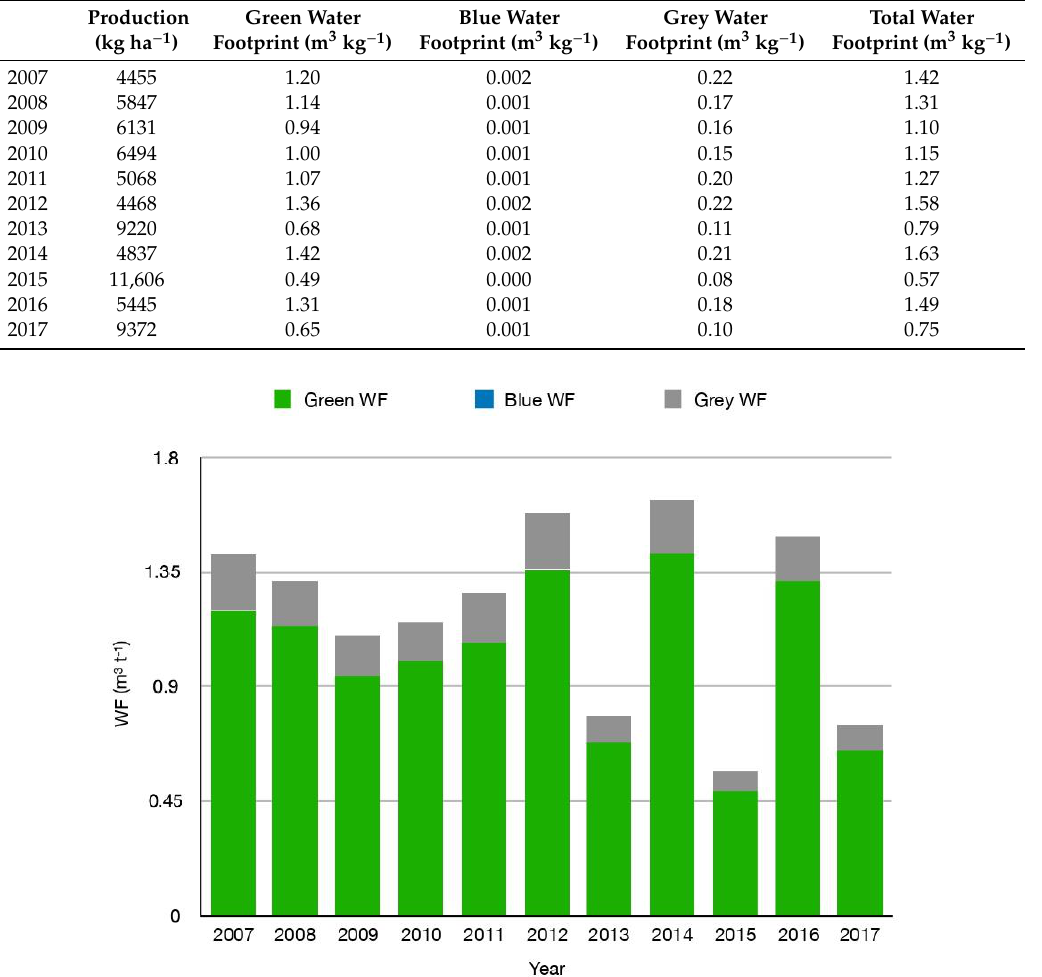
Figure 1. Yearly Green, Blue, Grey and total Water Footprint (m 3 t −1 ) compared with olives yearly production (kg ha −1 ). 3.1. Green Water The maximum value for the Green water was 1.42 m 3 kg −1 (year 2014) while the lowest value was equal to 0.49 m 3 kg −1 (year 2015). The difference is due to a higher olives production in 2015 that was about 2.5 times than in 2014. The lower production in 2014 was due to a massive attack of olive fly. Moreover, 2014 has higher minimum temperature in January and February compared to the average of the considered period. 3.2. Blue Water 3.2.1. Direct Fraction